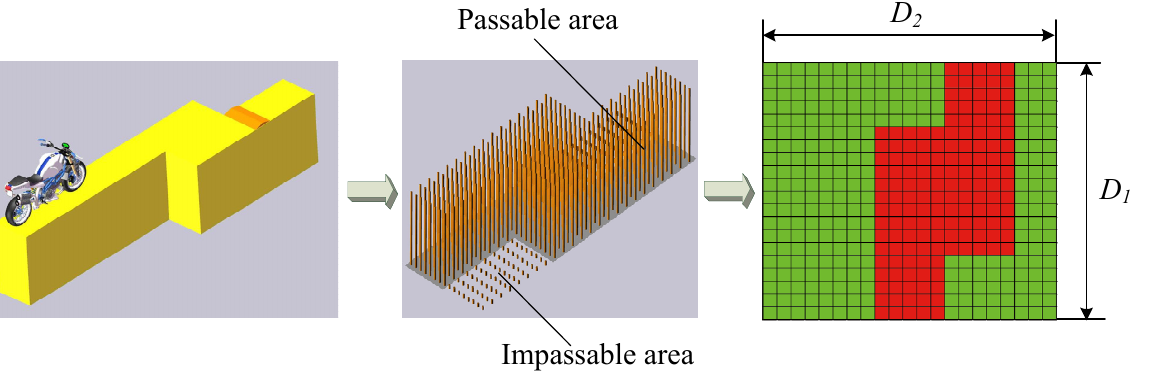
Figure 2. State s A settings.